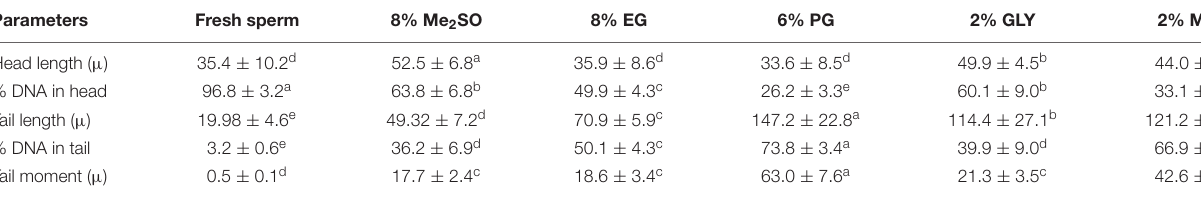
TABLE 5 | Comet assay parameters (mean ± standard deviation) of fresh and cryopreserved sperm samples of H. discus hannai . Parameters